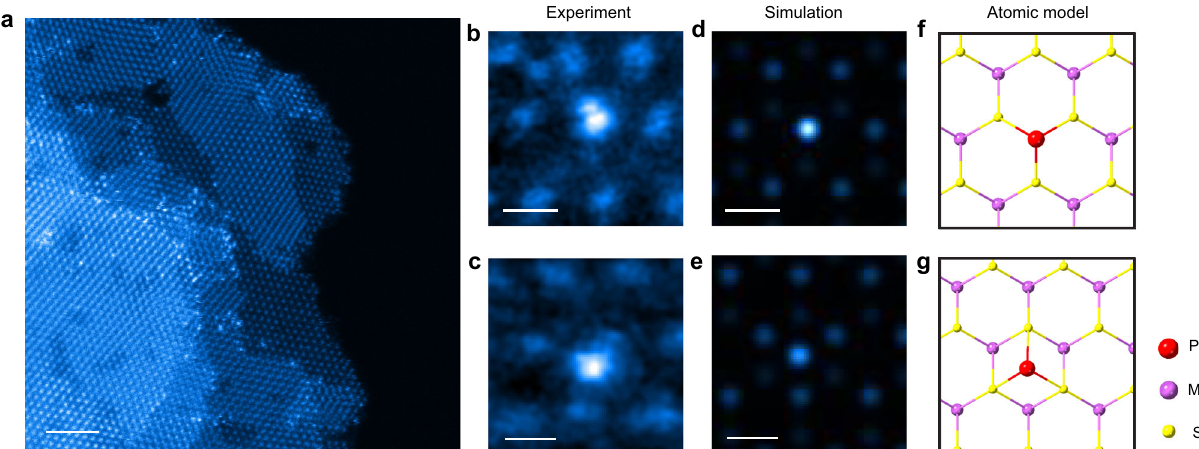
Fig. 2 Identi fi cation of the Pt single atoms in the as-prepared catalyst. a Atomic-resolution STEM-HAADF image of Pt 1 -MoS 2 (details in Supplementary Fig. 2); b Magni fi ed view of a Pt atom adsorbed atop of Mo (dominant species, 93% in STEM images); ( c ) Pt atom in the hollow of the honeycomb structure (minor species, 7%). d , e The corresponding HAADF image simulations and f , g atomic models of the catalyst, f Pt directly adsorbed on top of Mo; g Pt adsorbed on hollow site of hexagon. Scale bar: a, 2 nm; b-e, 0.2 nm.